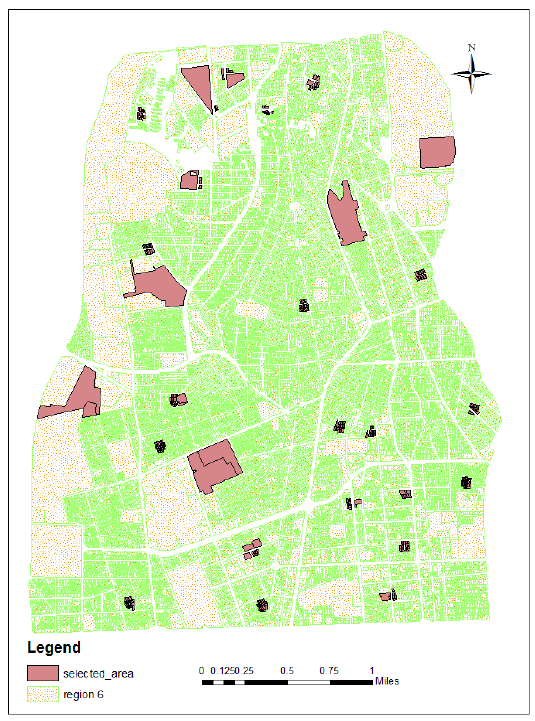
Figure 4. Appropriate sites for healthcare services